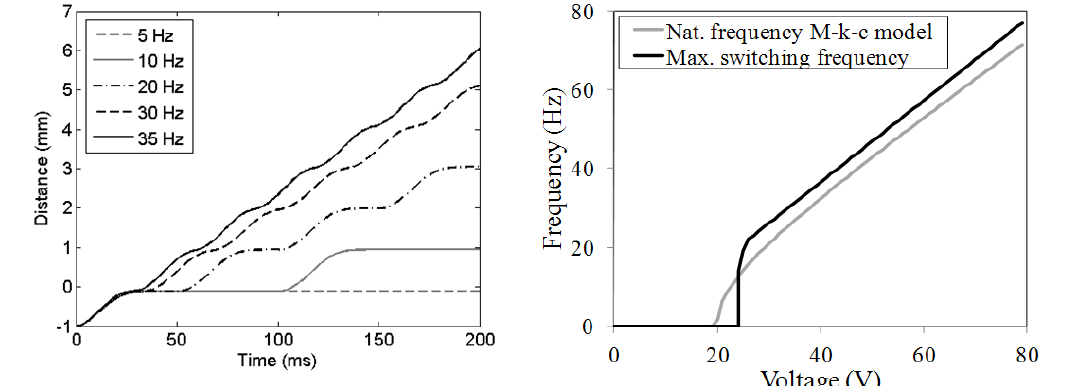
Figure 9. Maximum switching frequency as a function of the actuation voltage for the planar electrode configuration with air as filler liquid and with the system parameters listed in Table 1. The switching frequency is compared for the results of the dynamic model using the actual force profile and the results of the linearized damped spring-mass model (two times the natural